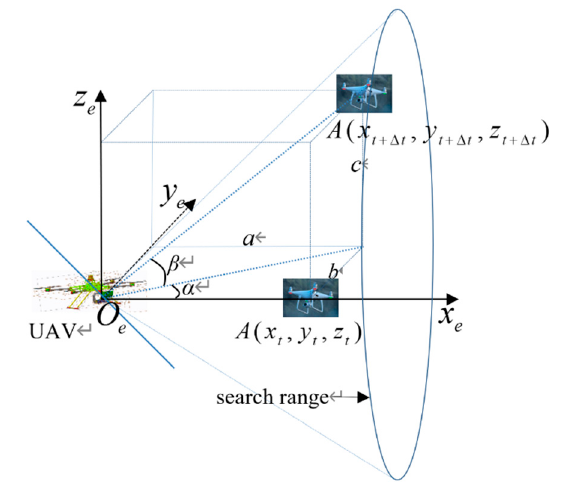
Figure 19. 2-DOF PTZ tracking coordinate diagram.